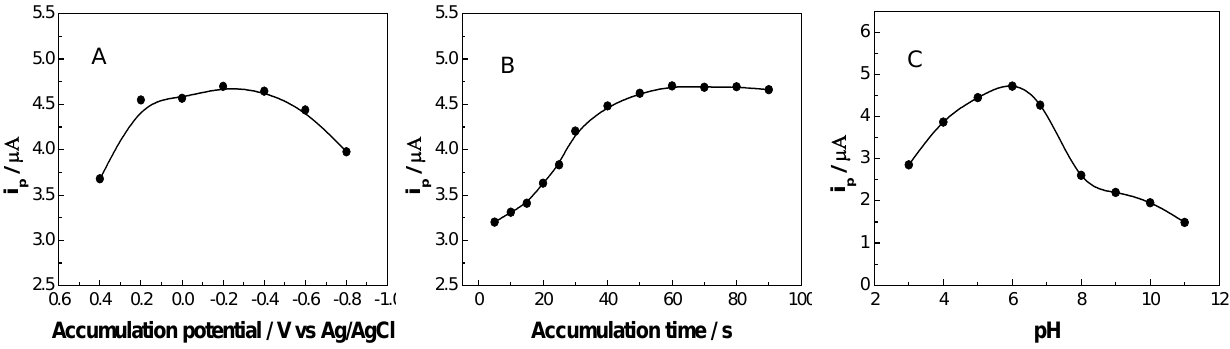
Figure 3. (A) Effect of accumulation potential on the anodic peak current of the DPV. (B) Effect of accumulation time on the anodic peak current of the DPV. (C) Effect of pH on the anodic peak current. DA: 5.0 × 10 -7 M, the other experimental parameters are similar to Figure 1(A).